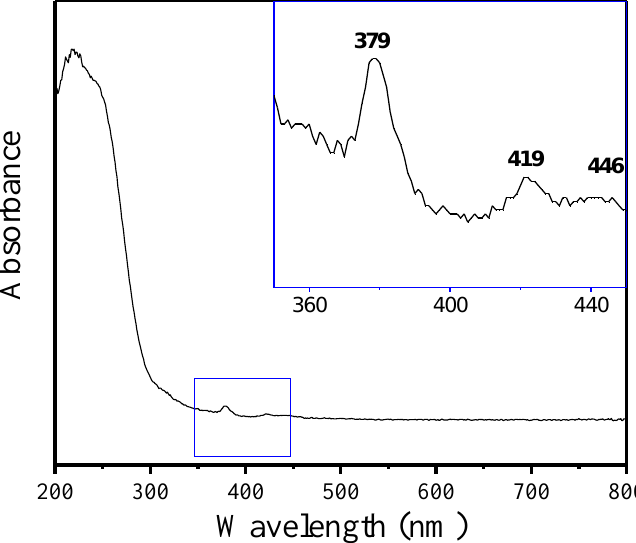
Figure 5. UV-vis spectrum of as-synthesized